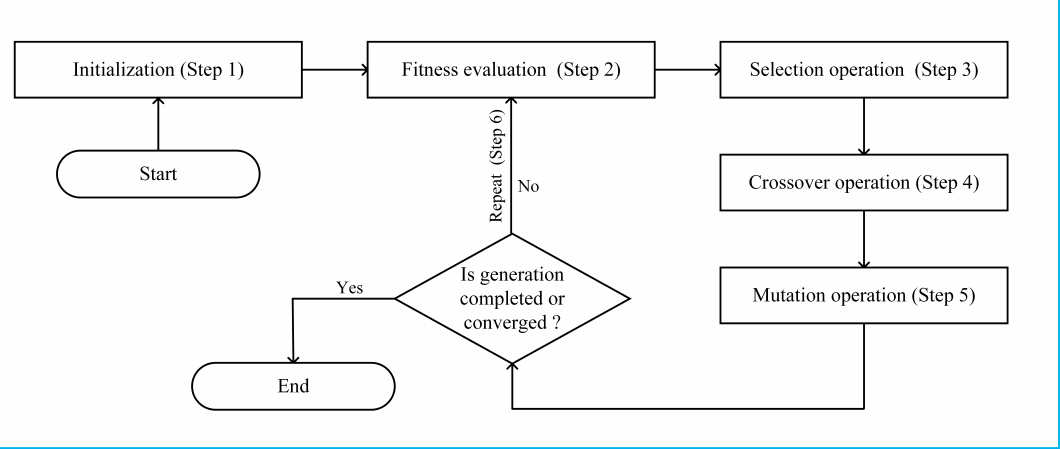
Figure 2. Flowchart of the proposed